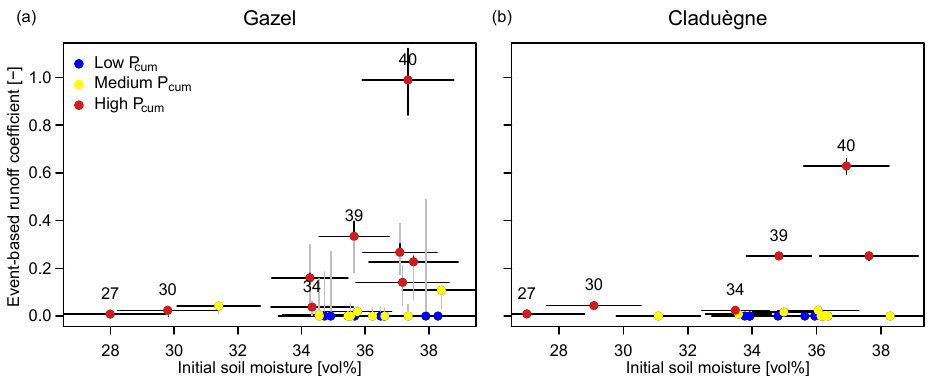
Figure 9. Relationship between initial soil moisture e θ ini and event-based runoff coefficients φ ev in the Gazel (a) and Claduègne (b) catch- ments. On the x axis the point represents the profile mean initial soil moisture and the horizontal line the range of the mean ± SEM inter cat . . On the y axis the point represents φ ev calculated with the recursive digital filter method and the line the uncertainty as in Fig. 7. The color of the points indicates whether cumulative precipitation is low ( P cum < 1 . 5mm), medium (1.5mm < P cum < 13mm) or high ( P cum >